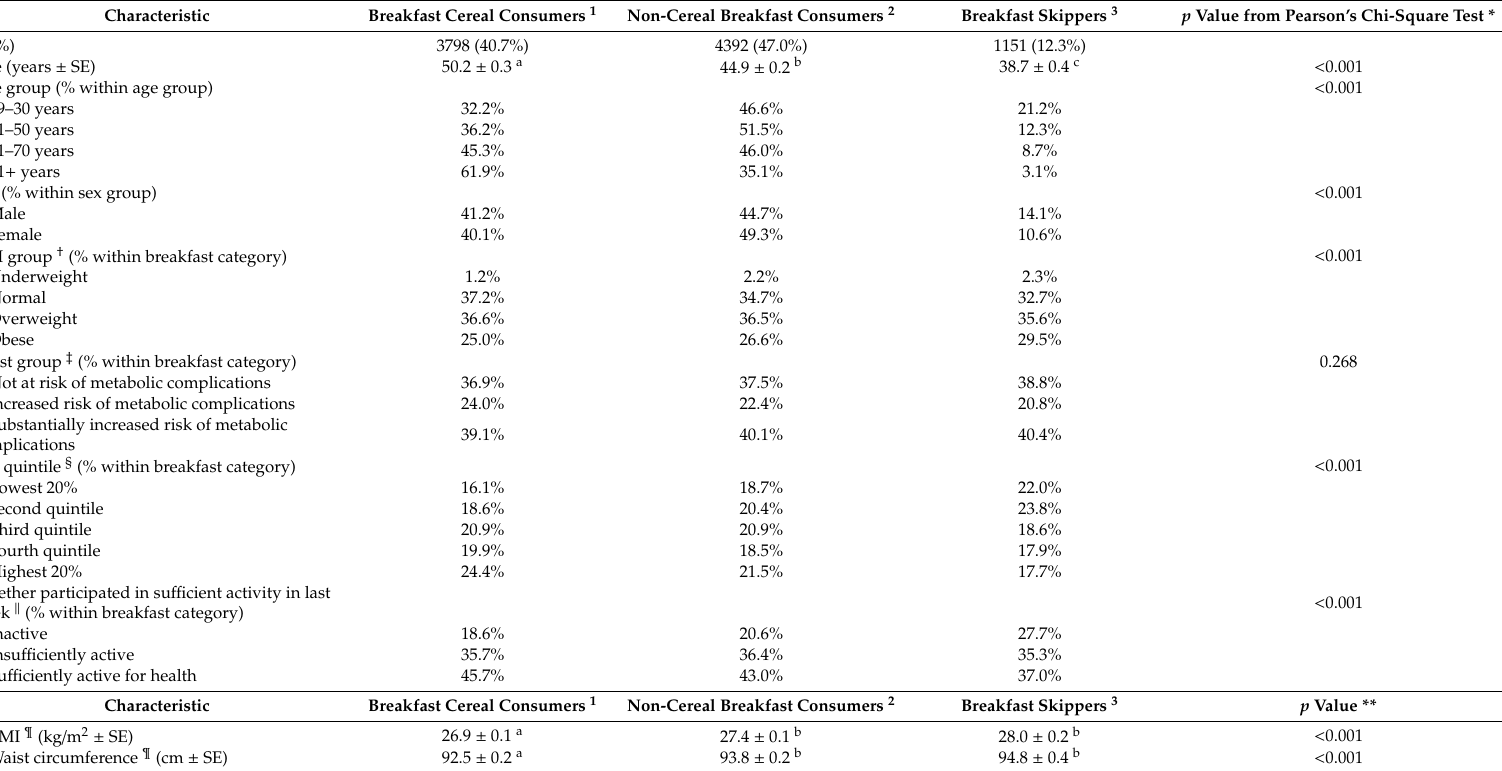
Table 1. Socio-demographic, anthropometric, and physical activity measures by breakfast consumer